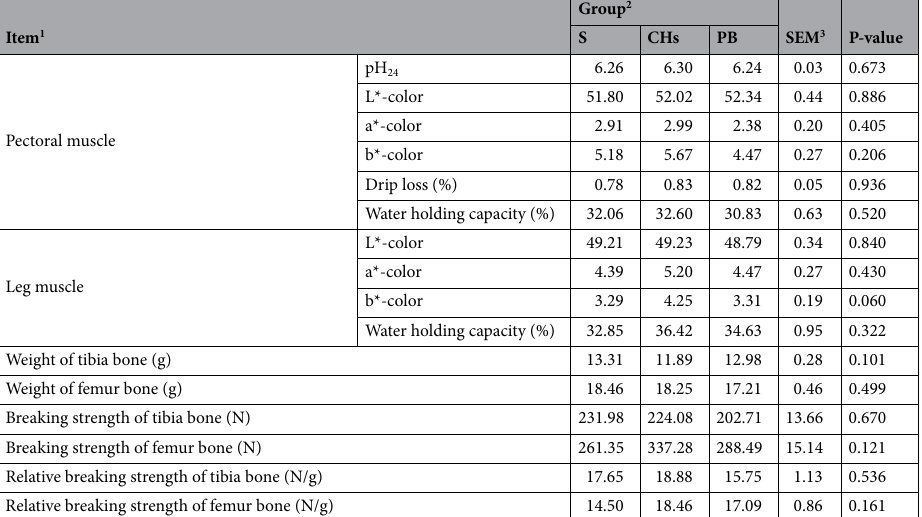
Table 5. Physicochemical features of broiler chicken muscles and bones. No statistically significant differences between the groups were found, P-value > 0.05; 1 , L*, lightness; a*, redness; b*, yellowness; 2 , S, chopped wheat straw bedding; CHs, crude coffee husks bedding; PB, pelleted bedding with 50% of chopped wheat straw and 50% of coffee husks; 2, SEM, standard error of the